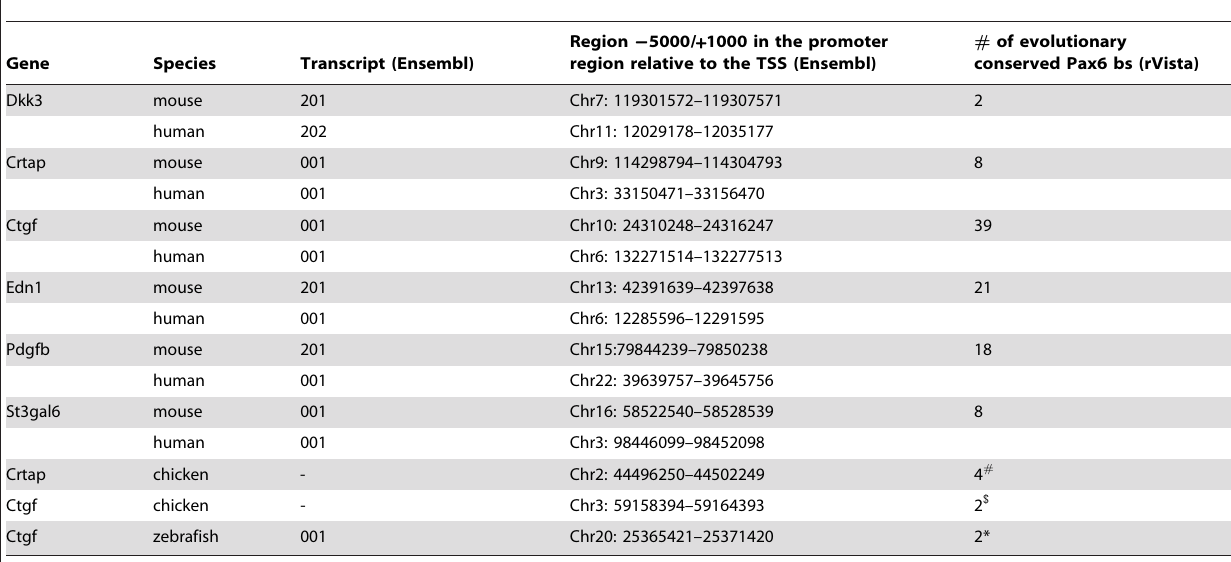
# Four of the eight sites evolutionary conserved between mouse and human are also conserved in chicken Crtap. $ Two of the 39 sites conserved between mouse and human Ctgf gene are also conserved in chicken, one of these two sites is in addition conserved in zebrafish. *Two of the 39 sites conserved between mouse and human Ctgf gene are also conserved in zebrafish, one of these two sites is in addition conserved in chicken.